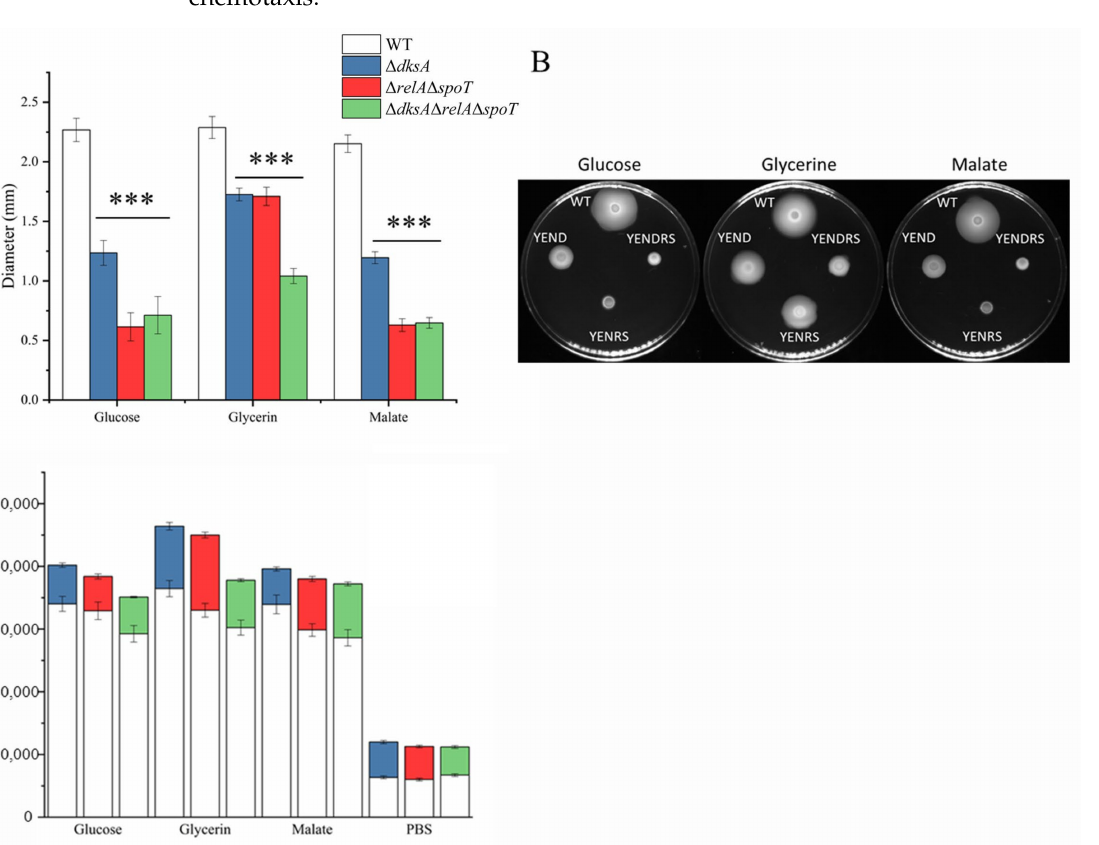
Figure 7. Comparison of the chemotactic responses of WT and mutant strains in three carbon resources. ( A ) Quantification of swim diameters. ( B ) Images of a swim plate. ( C ) Competitive chemotactic responses of WT and mutant strains. The data are presented as the mean ± SD of at least three biological repeats, and the error bars indicate standard deviations. An asterisk indicates a significant difference (*** p <